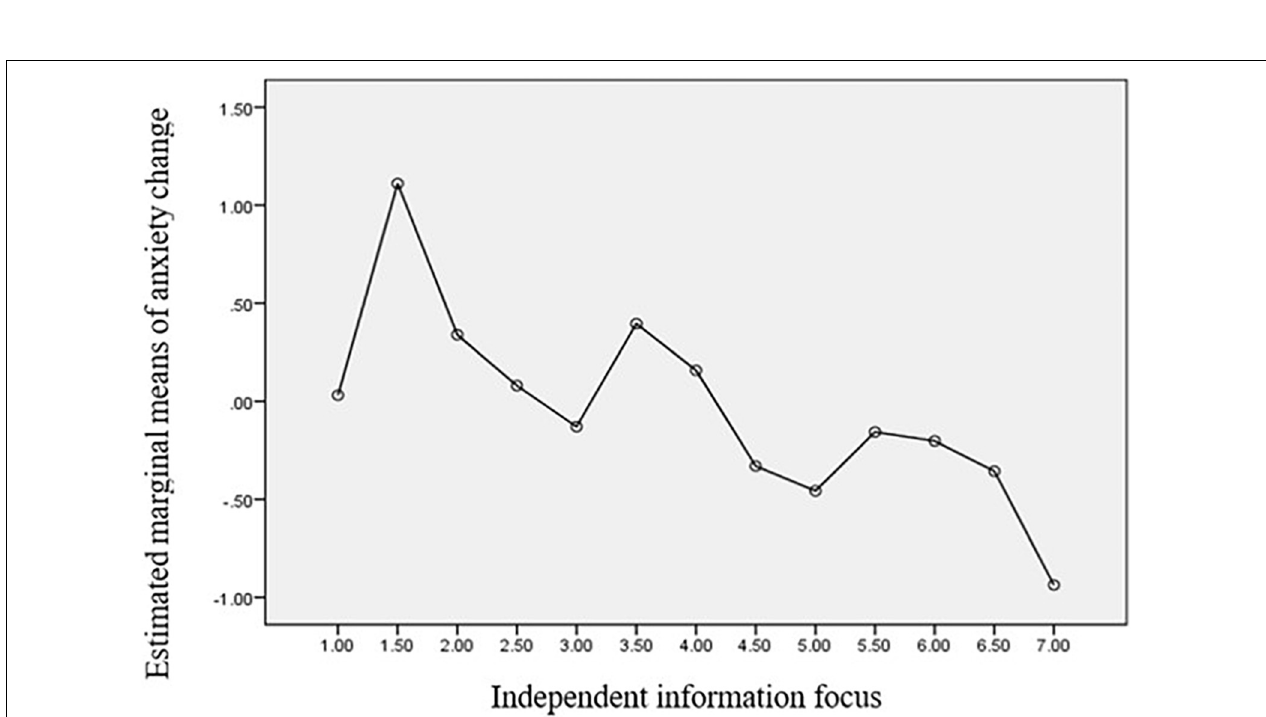
FIGURE 3 | Estimated marginal means of anxiety